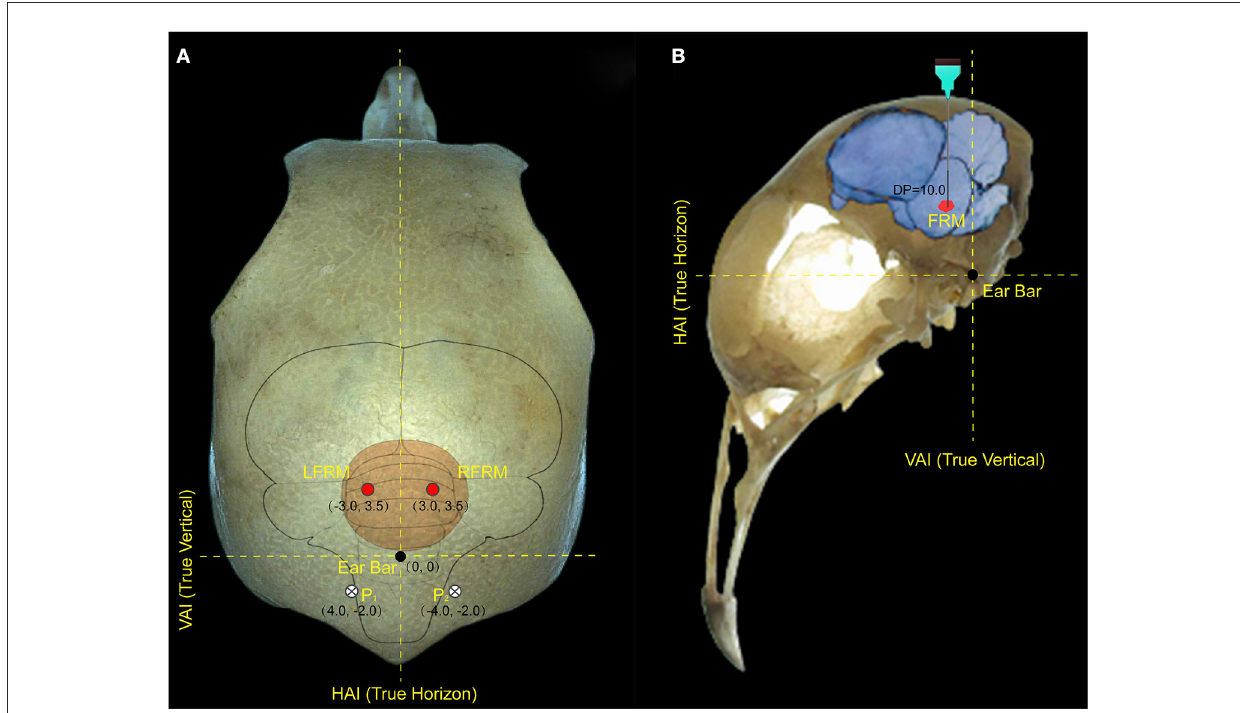
FIGURE1 Locations of electrode implantation in the pigeon brain. (A) represents the implantation position of the electrode on the surface of the pigeon skull, and (B) represents the implantation depth of the electrode in the pigeon brain. The intersection of the true vertical lines and true horizon lines in the pigeon head denotes the center of the ear bar. LFRM, RFRM denotes the left and right sides of formatio reticularis medialis mesencephali, respectively; HAI and VAI represent the horizontal and vertical axes of the brain stereotaxic apparatus, respectively; while P1 and P2 denotes the reference electrode implanted above the biparietal suture